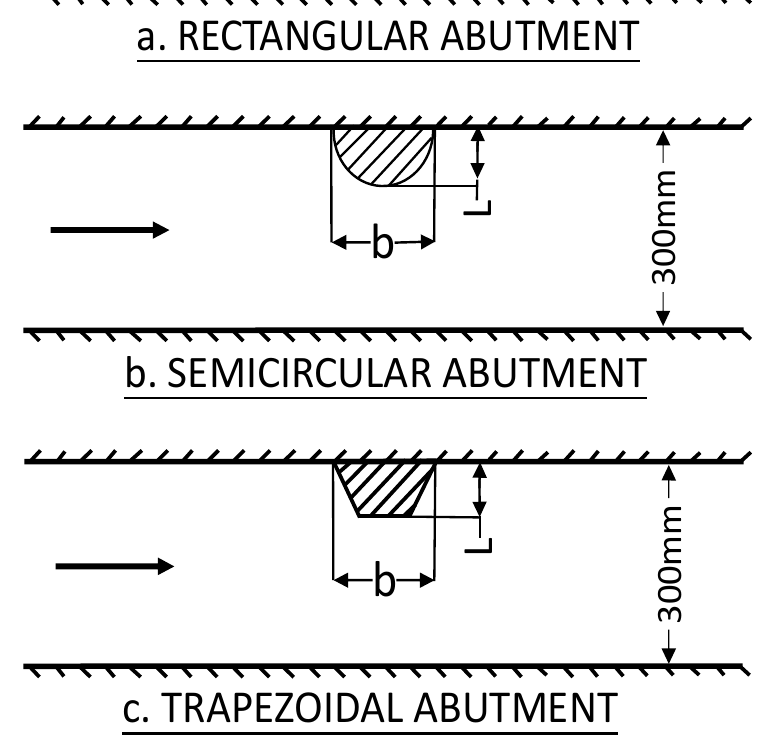
Figure 1. Top view of abutment models.